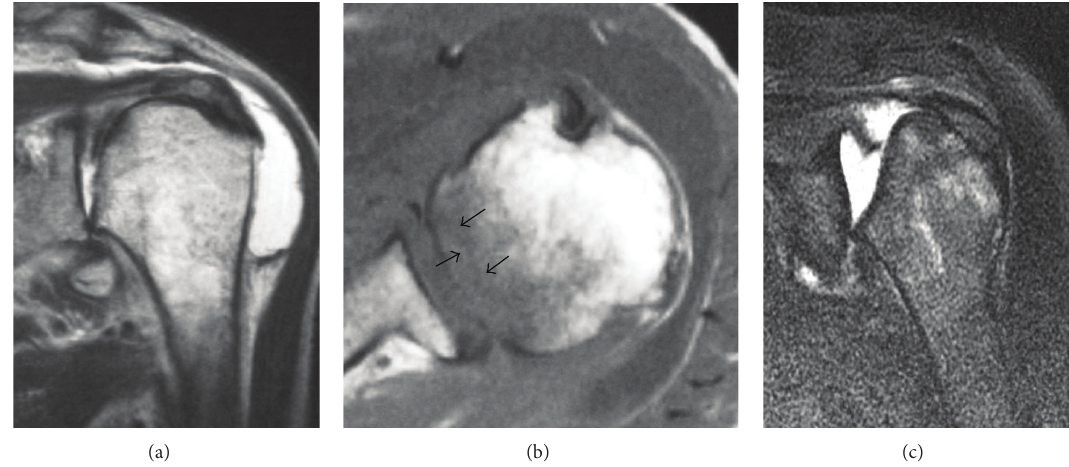
Figure 4: Case 2. Magnetic resonance image (MRI) of the left shoulder at symptom onset (a, b) and at the first visit to our hospital (c). (a) T2-weighted MRI (oblique coronal plane) demonstrates joint effusion and a slightly collapsed humeral head. (b) Axial, T1-weighted MRI shows a subchondral serpiginous pattern of low signal intensity with associated bone marrow edema. (c) T2-weighted MRI (coronal view) demonstrates the collapse of the humeral head and an intact rotator